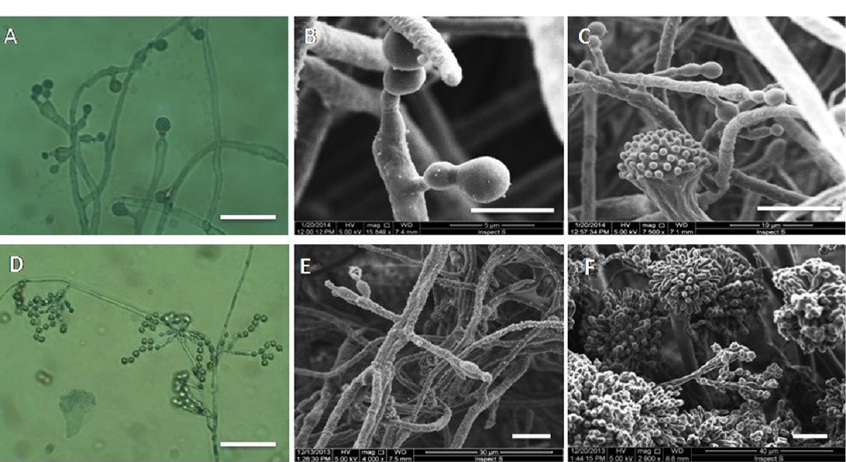
Fig. 5. Bright field and scanning electron micrographs. Top row shows the accessory conidia in Aspergillus terreus grown on MEA. Bottom row shows the phialidic conidia on penicillium like structure in Aspergillus versicolor on MEA (Bars: A & D = 400 µ m; B =5 µ m; C,E,&F = 10 µ